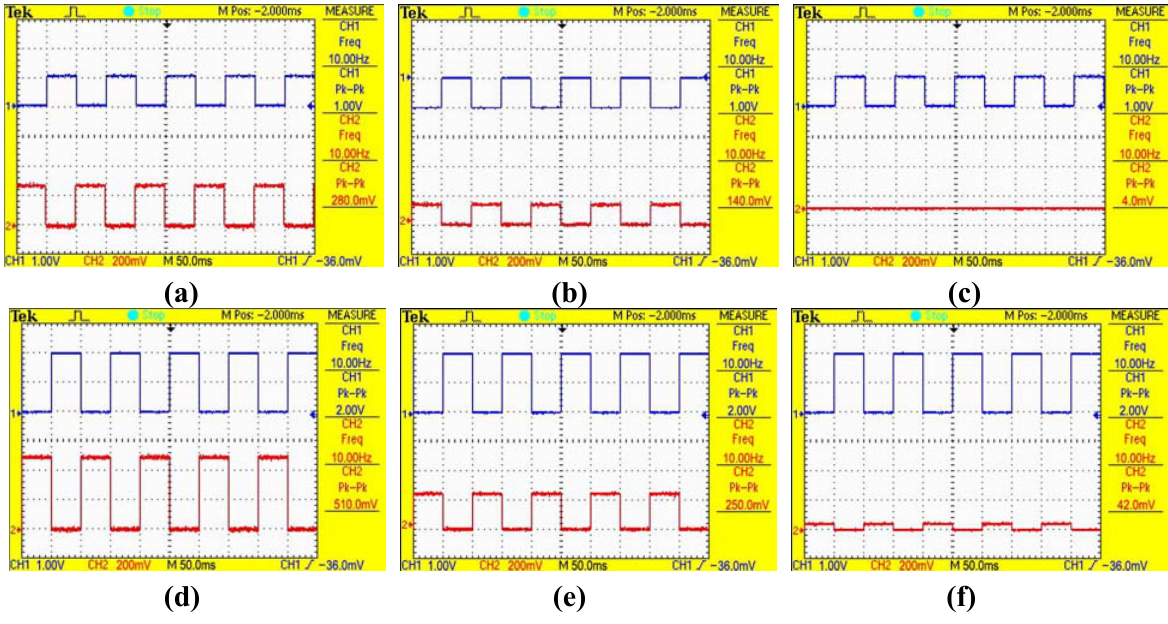
Figure 12. The ±1 st order diffraction light intensities of the different pixels when an all- selected pixel is actuated by different square-waves. (a) all-selected pixel when actuated by a 1V square-wave. (b) half-selected pixel when an all-selected pixel is actuated by a 1V square-wave. (c) non-selected pixel when an all-selected pixel is actuated by a 1V square- wave. (d) all-selected pixel when actuated by a 2 V square-wave. (e) half-selected pixel when an all-selected pixel is actuated by a 2V square-wave. (f) non-selected pixel when an all-selected pixel is actuated by a 2V